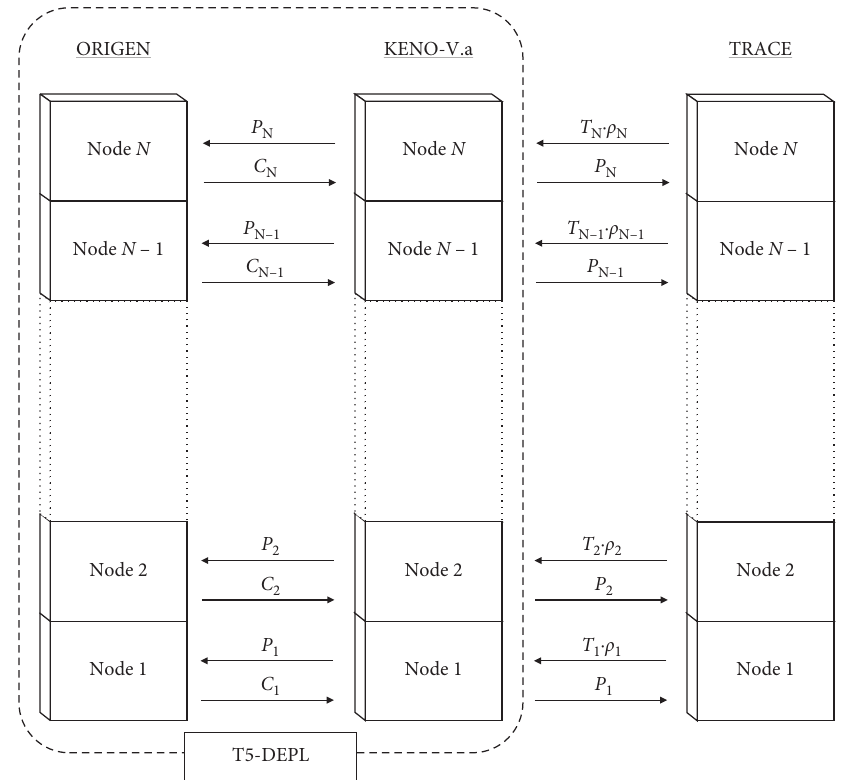
Figure 2: Two-way coupling of T5-DEPL and TRACE